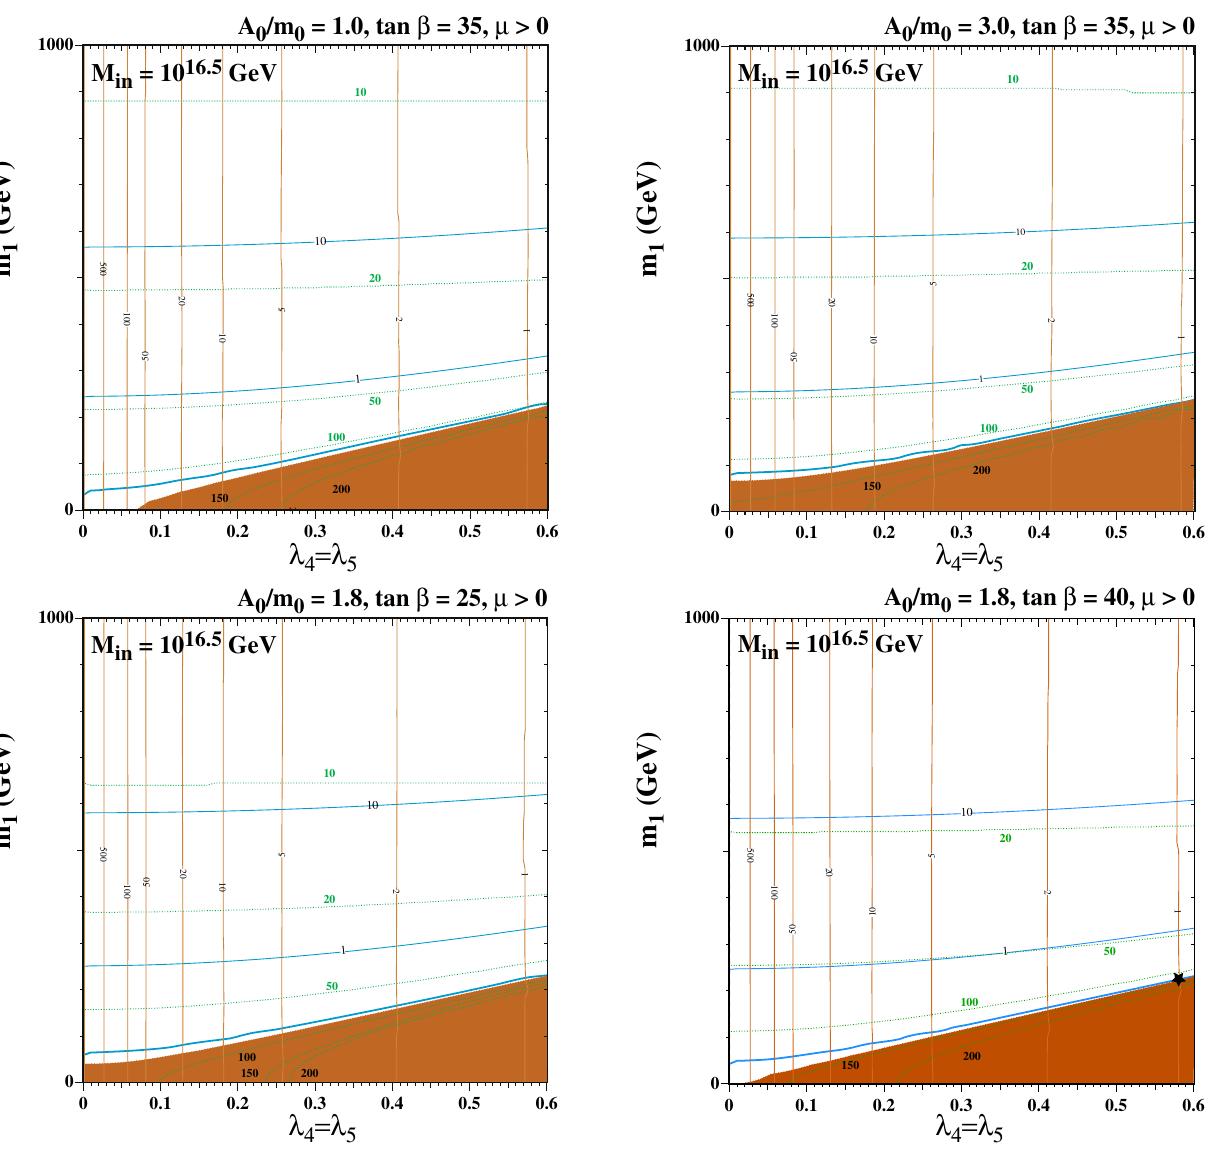
Fig. 11 As in Fig. 10, but for different choices of A 0 / m 0 = 1 , 3 (upper left and upper right panels) and of tan β = 25 , 40 (lower left and right panels). The contours are as in Fig. 1. The star in the lower right panel represents a benchmark point with spectrum given in the